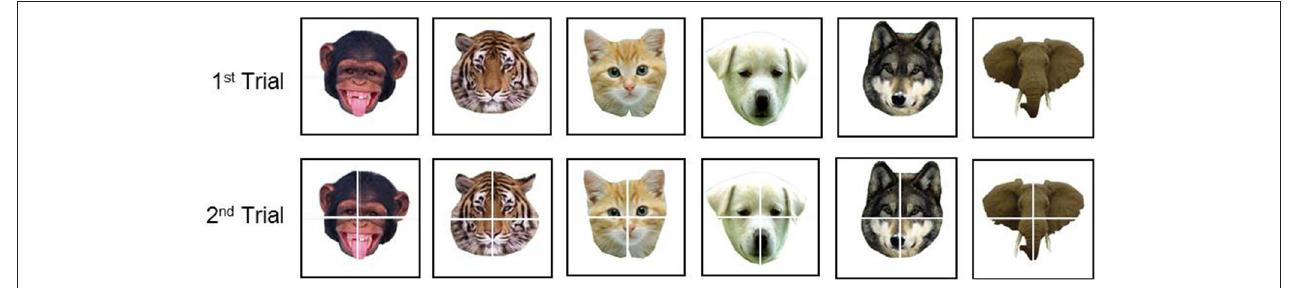
FIGURE 7 | Six TAG-Game A -AF items. If one does not successfully assemble the blocks correctly to match the face in the first trial, the second trial shows thin grid lines to separate the image segments. C play A = 22.92 for all items.